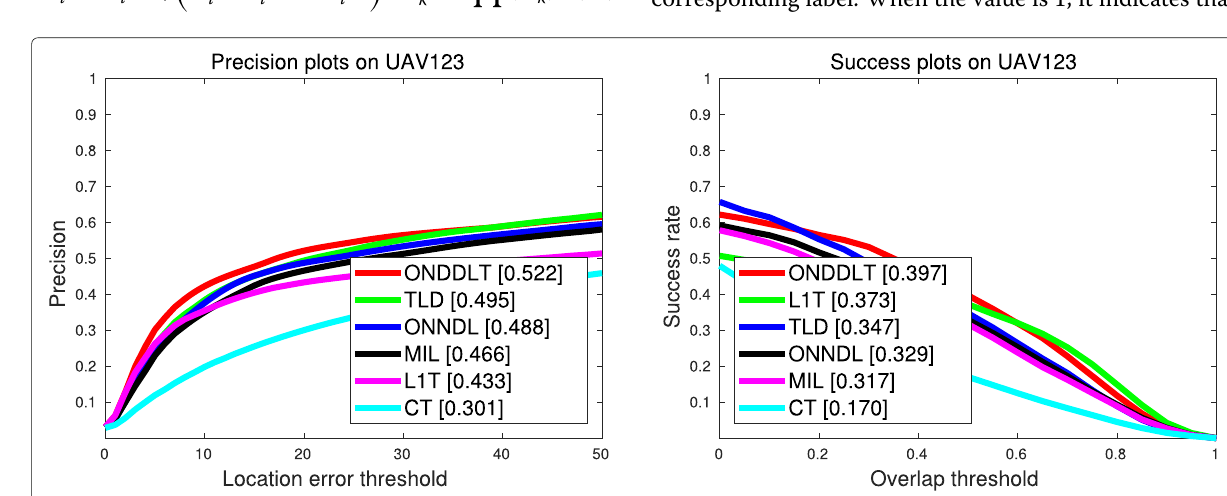
Fig. 2 Success plots of IPR, IV, LR, and BC attributes on the OTB100